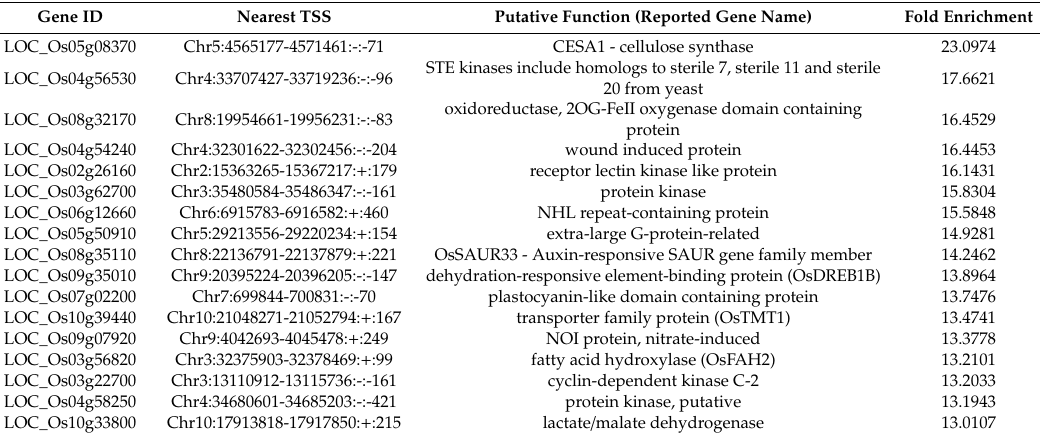
Figure 5. ChIP-Seq and Random DNA Binding Selection Assay (RDSA) data analyses. ( A ) Distribution of OsbZIP81.1 binding sites in the genic regions of the rice genome. ( B ) Statistics of distribution of OsbZIP81.1 binding sites in the rice genome. ( C ) Information regarding the most significant motif identified in the OsbZIP81.1 binding peaks with Multiple EM for Motif Elicitation (MEME). ( D ) Electrophoretic mobility shift assay (EMSA) assay. Glutathione S-Transferase (GST) tagged OsbZIP81.1 protein and biotin-labeled, or unlabeled TAGCTGGC sequences were used in the experiment. The concentration of unlabeled sequence was 200 times that of the biotin-labeled sequence. ( E ) Information regarding the most significant motif identified in the RDSA experiment. Table 2. List of genes and their putative function in the